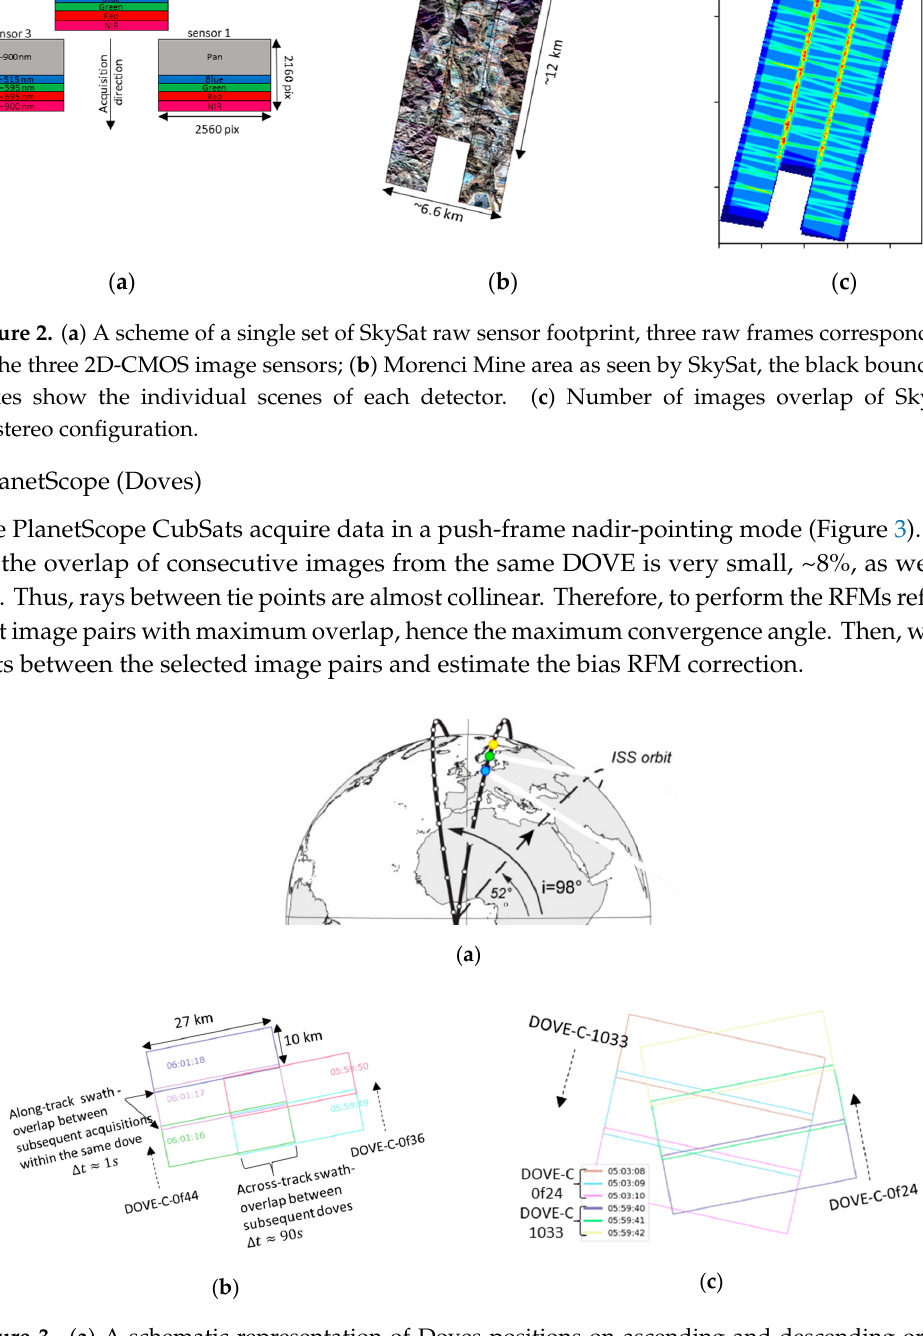
Figure 3. ( a ) A schematic representation of Doves positions on ascending and descending orbits, modified from [25] . ( b ) Projection view of Doves footprints (Dove-C- of44 and Dove-C–of36) featuring along-track overlap between subsequent acquisitions of the same dove, and across-track overlap between successive doves in the same orbit. ( c ) Projection view of Doves footprints featuring overlap between ascending (Dove-C–0f24) and descending (Dove-C-1033) acquisitions. Rectangles denote individual dove footprint and each color represent the time acquisition. Dash arrows depict the direction of the dove acquisition as seen on